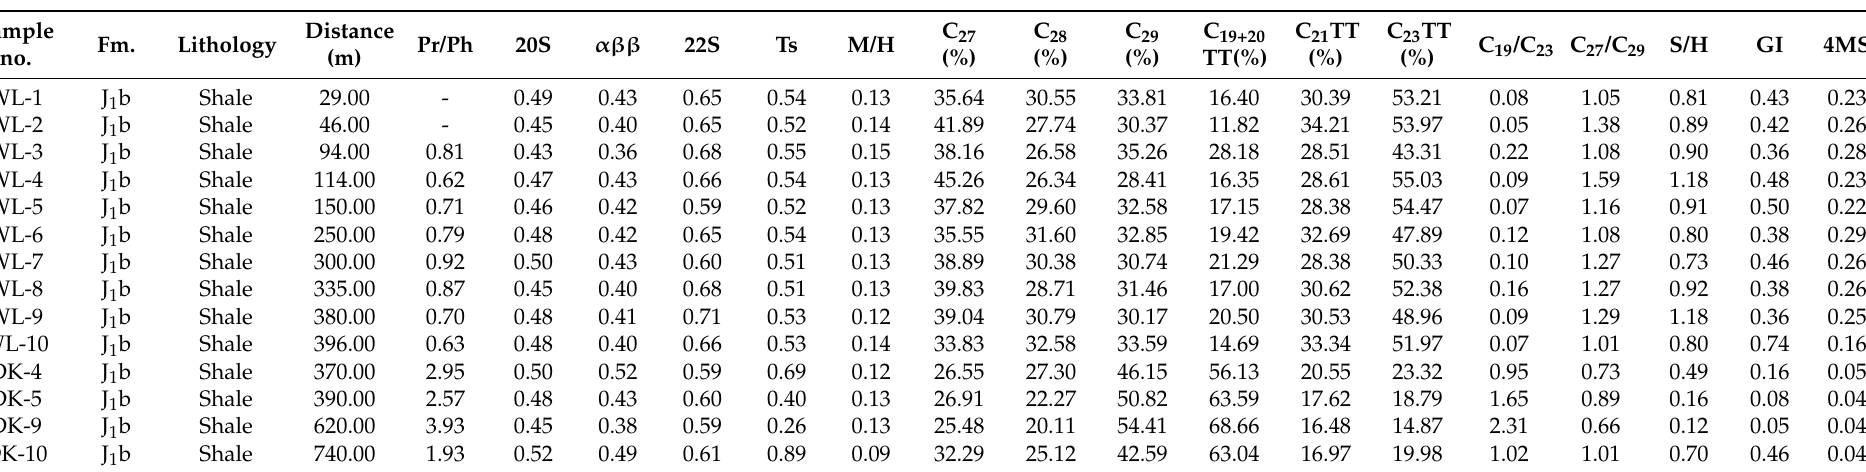
Table 3. Biomarker parameters of the Beipiao